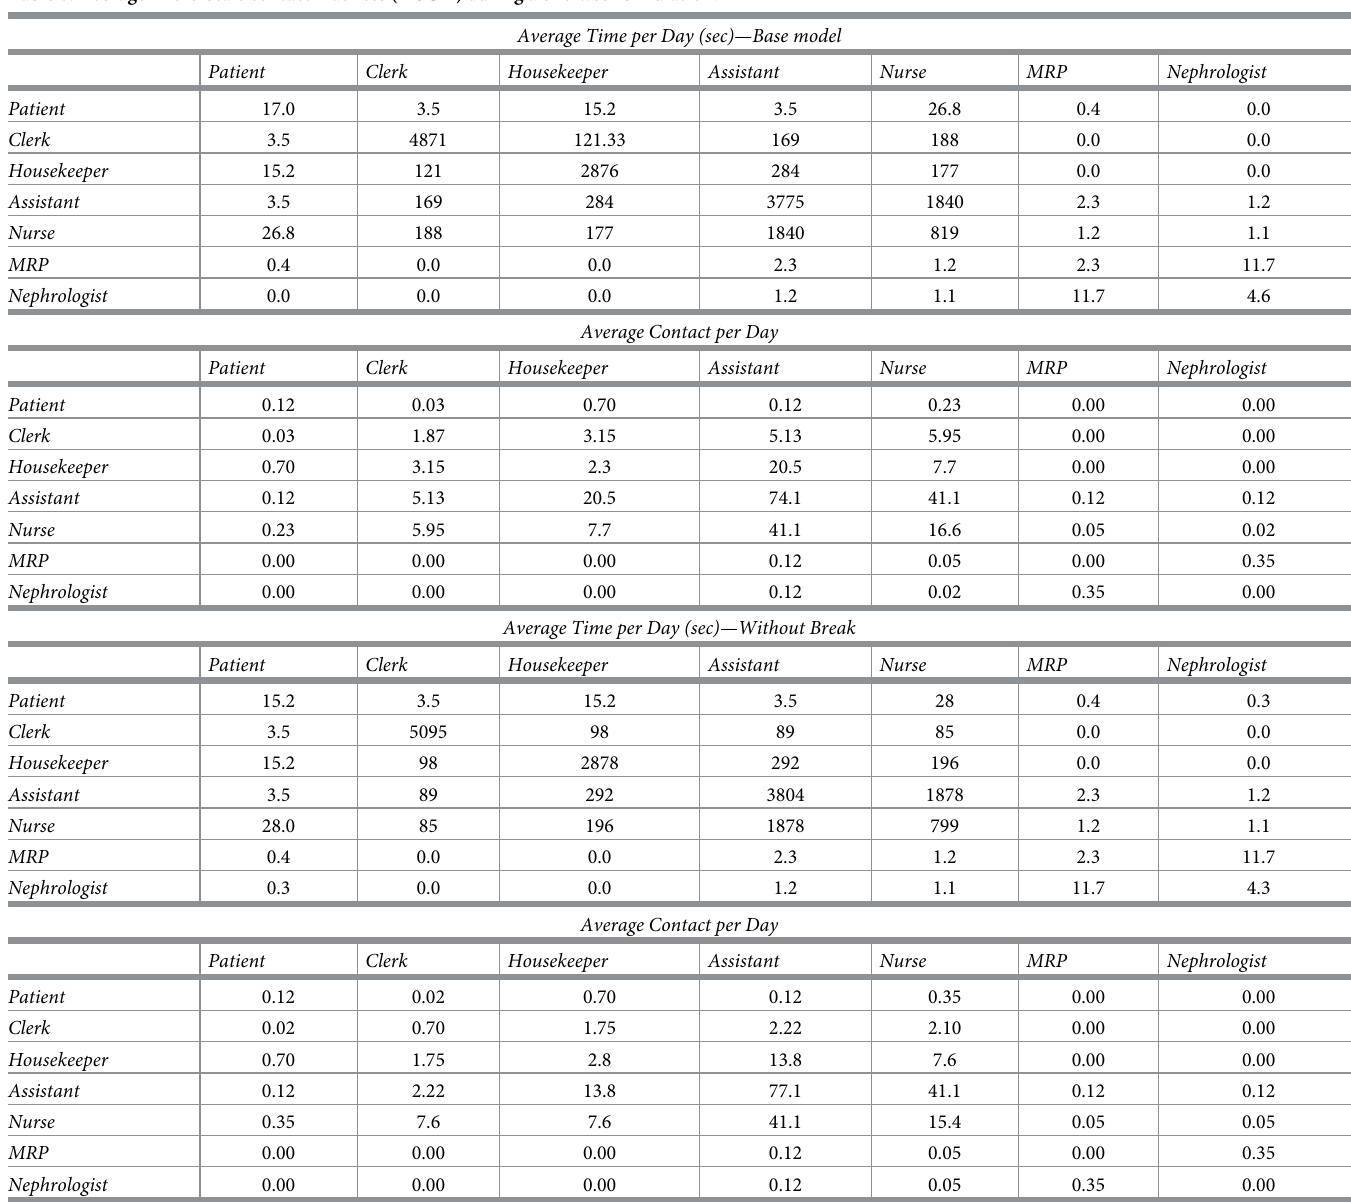
Table 6. Average micro-scale contact matrices (MSCM) during a one-week simulation. Average Time per Day (sec)—Base